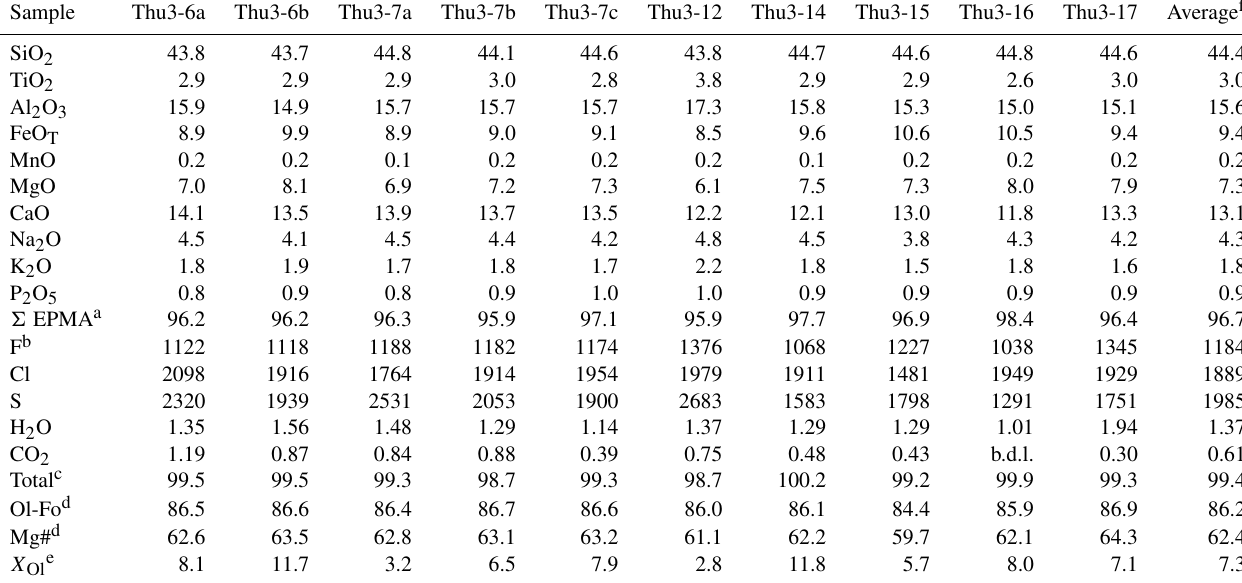
Table 2. Glass compositions of unheated melt inclusions. The compositions are corrected from post-entrapment crystallization with the software MIMiC (melt inclusion modification corrections; Rasmussen et al., 2020), using a ratio of Fe 3 + /(cid:54) Fe equal to 0.19 (Gaborieau et al.,